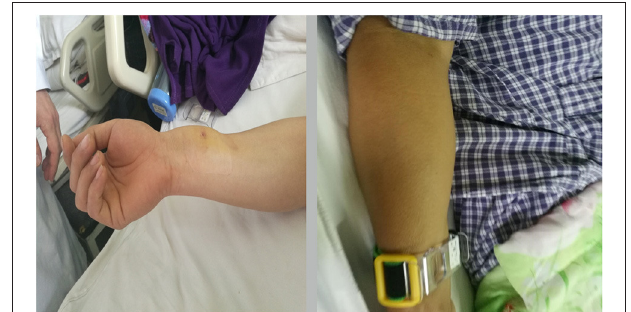
FIGURE 3 | Severe